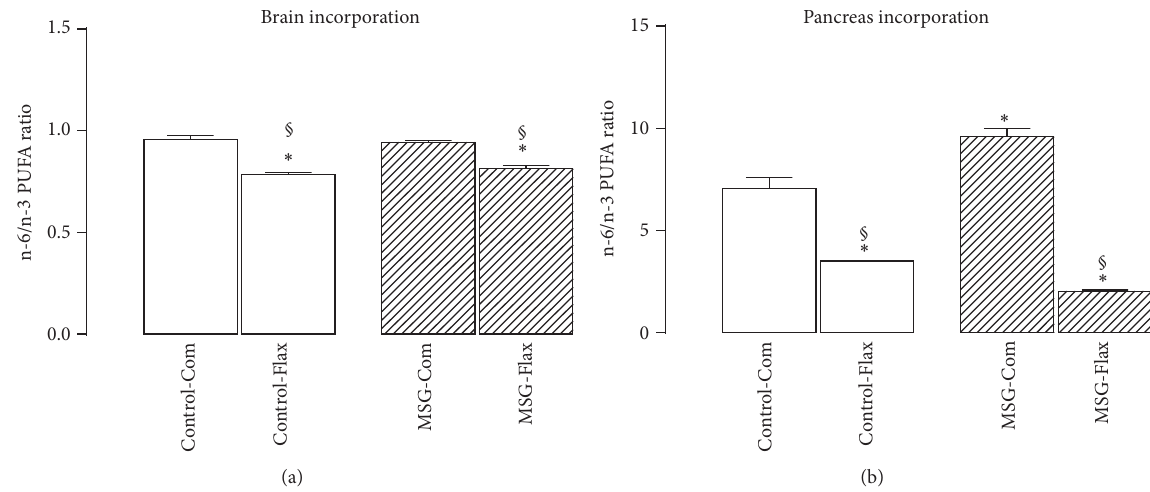
Figure 4: Polyunsaturated fatty acids (PUFAs) incorporation in the brain (a) and pancreatic (b) tissues from mice at 21 days of age. Bars represent the mean ± SEM of n-6/n-3 ratio for three replicates from samples obtained from 5 different litters ( 𝑛 = 5 ) of each group ( 𝑛 = 5 ). The letters over the bars represent significant differences among the groups based on one-way ANOVA, where ∗ depicts statistical difference with 𝑃 < 0.001 compared to Control-Com group and § 𝑃 < 0.001 depicts statistical difference compared to MSG-Com